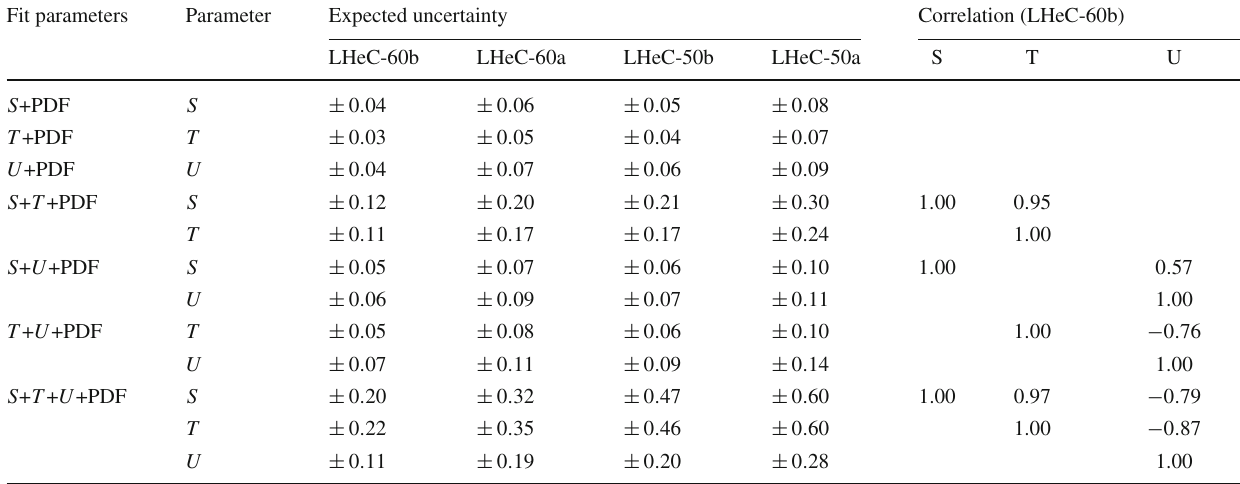
Table 6 Same as Table 5, but in the modified on-shell scheme with m Z and G F as fixed input parameters, i.e. m W is calculated Fit parameters